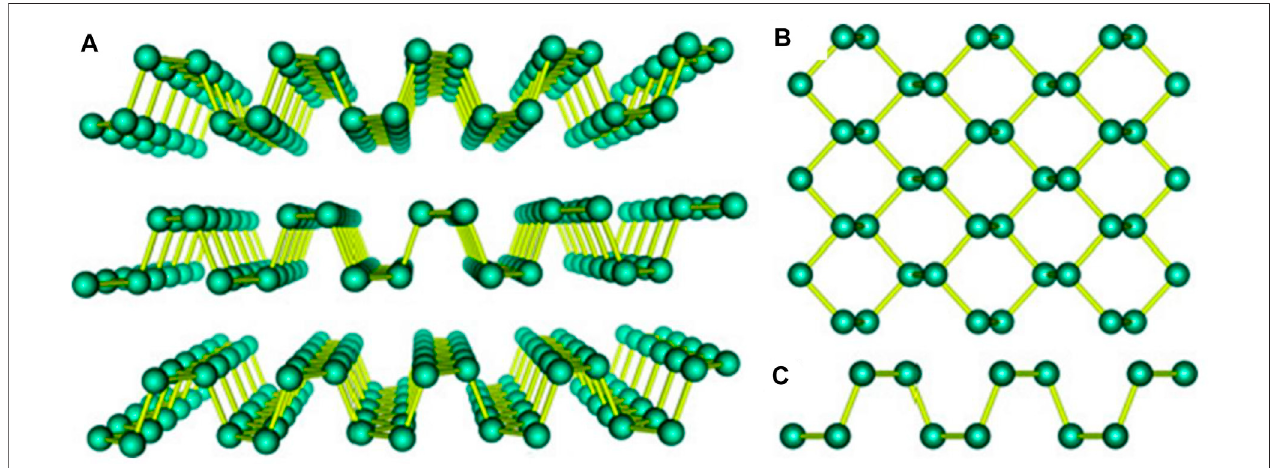
FIGURE 5 | (A) Multilayered crystal structure of black phosphorus (Shao et al., 2014), (B) Top view (Shao et al., 2014), and (C) Side view (Shao et al., 2014); Adapted with permission from (Shao et al.,